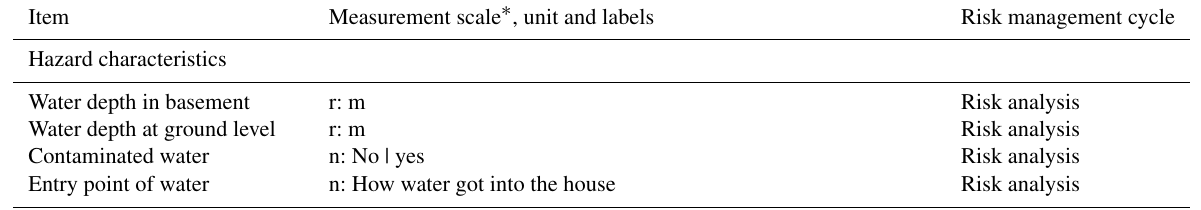
Table 2. Items of the questionnaires that were used in this paper.